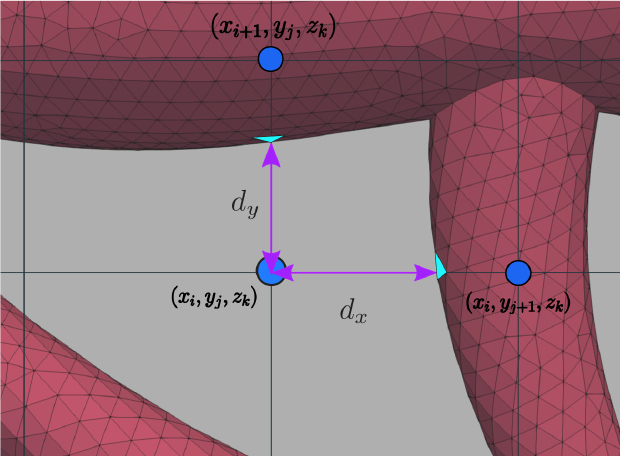
Figure 4. Computation of the distances between the grid node and the intersecting triangles in both x and y directions denoted respectively d x and d y